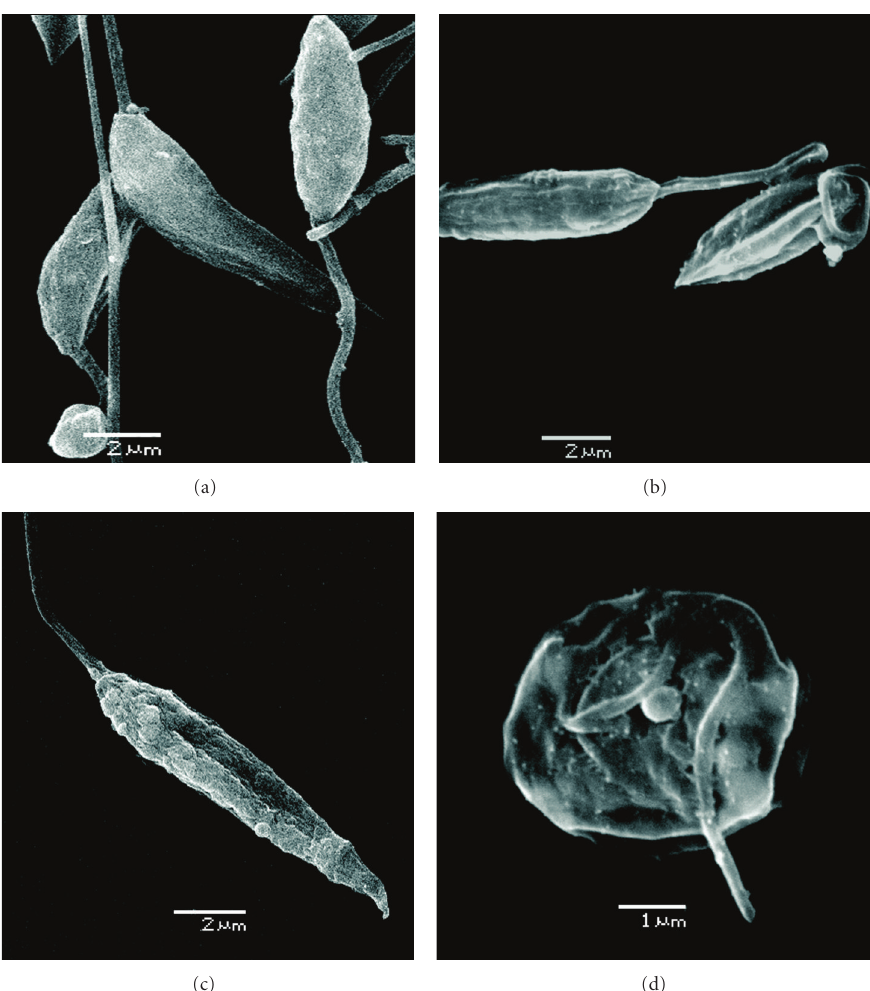
Figure 2: In (a) scanning electronmicrograph (SEM) of control L. chagasi , displaying the characteristic morphology of promastigotes. In (b), (c), and (d) SEM of warifteine-treated parasites, showing septa (b) “blebs” scattered over the plasma membrane (c) and rounded shape (d). Magnification 6.500 (a), 7.000 (b), 7.500 (c), and 13.000